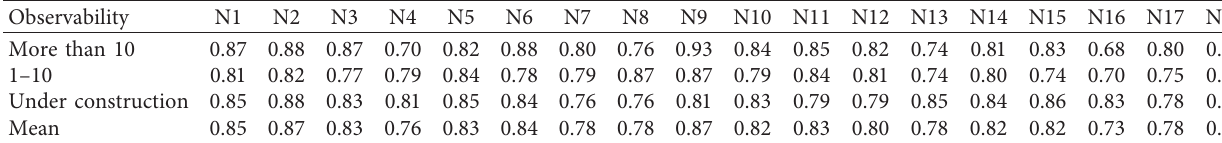
Table 10: The observability score of each BIM application area.